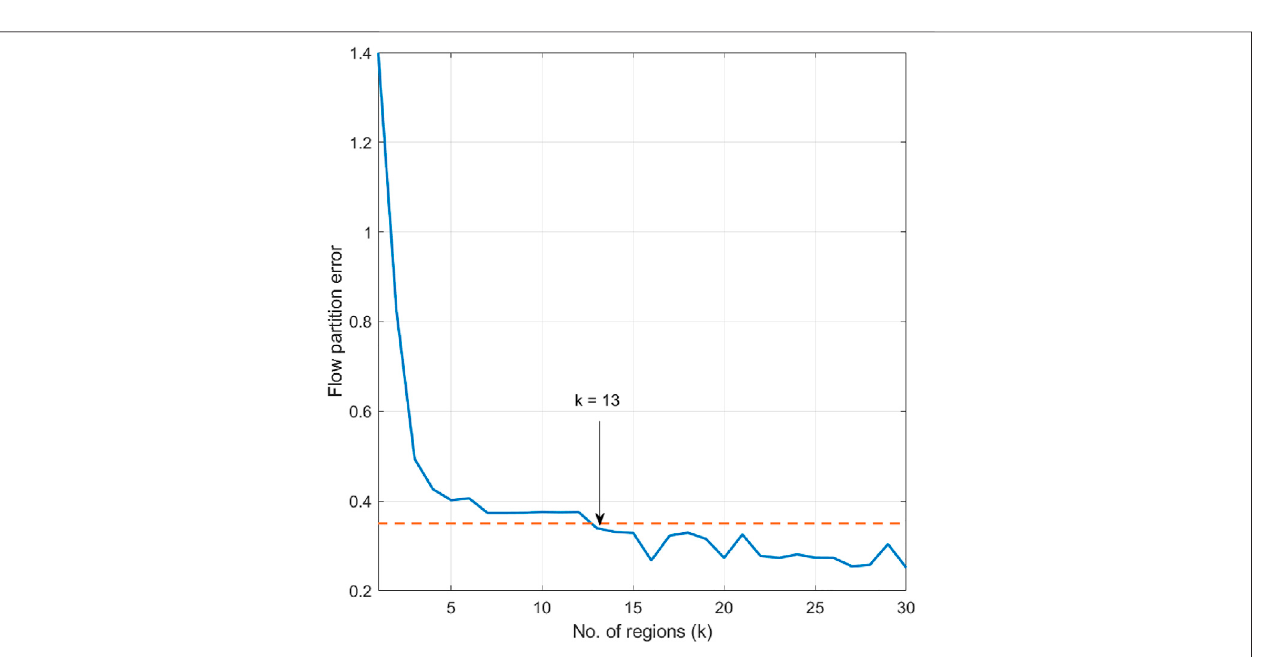
Frontiers in Robotics and AI |